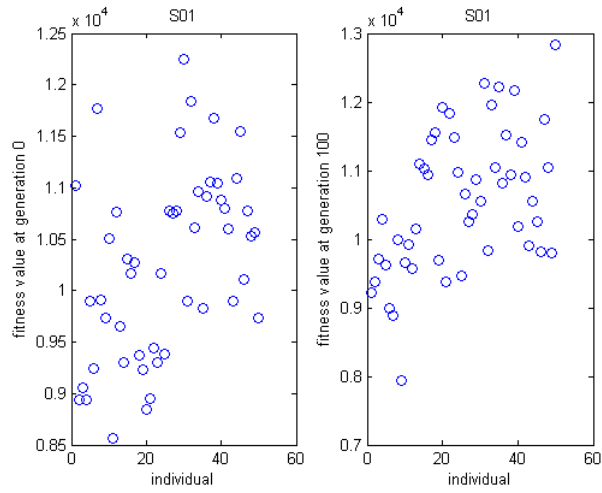
Figure 10. The distribution graph of fitness on MSO4 for F01.